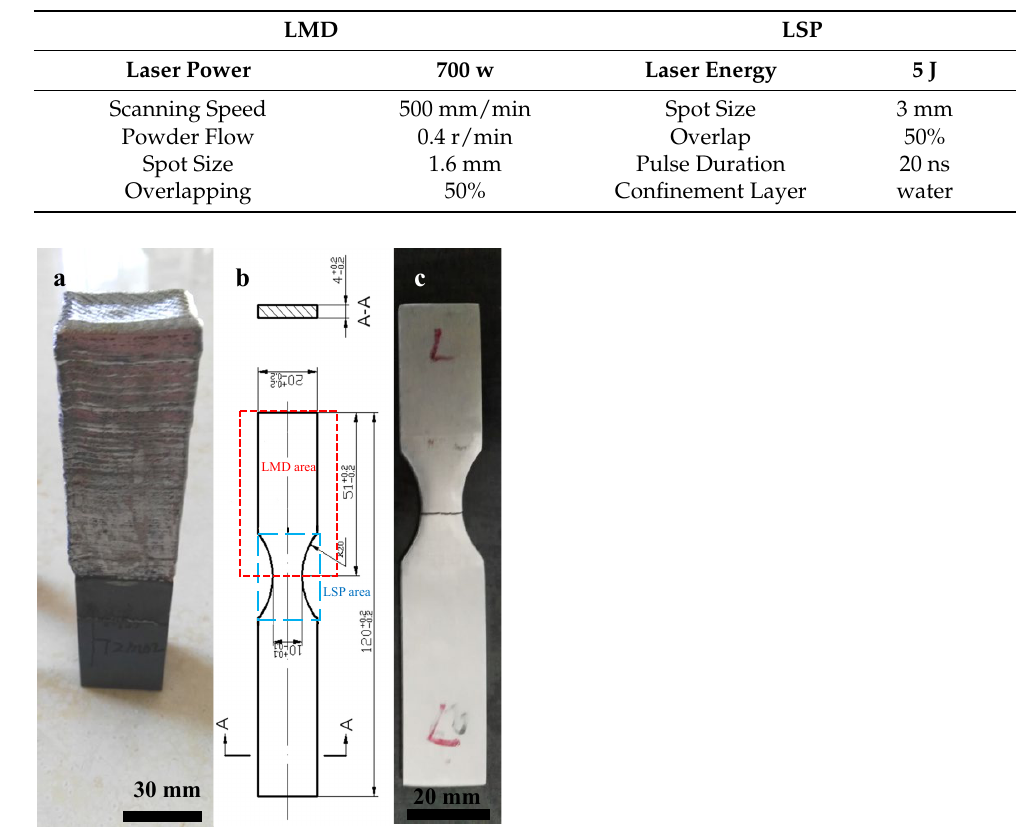
Figure 2. The laser repaired sample ( a ), the dimensions of the fatigue sample with LSP and LMD areas ( b ) and the fractured as-LMD sample ( c ).